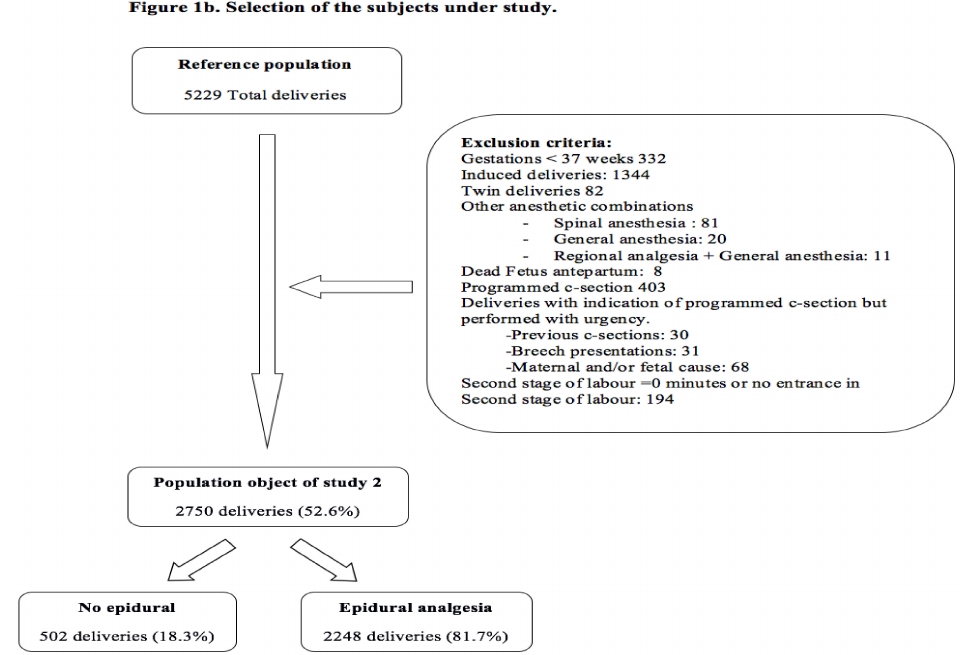
Figure 1. Selection of the subjects under study. ( a ) Population 1. Selection of the subjects under study. ( b ) Population 2. Selection of the subjects under study.